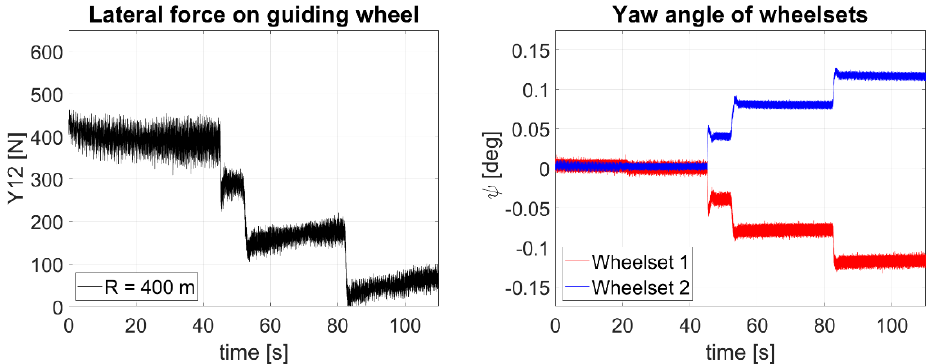
Figure 20. Measured data—active wheelset steering test, R = 400 m.